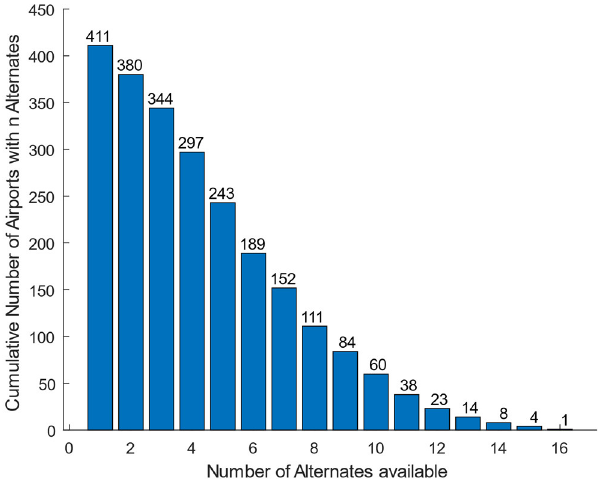
Figure 7. Cumulative number of airports that have n available alternates within reach by the defined reserve distance.